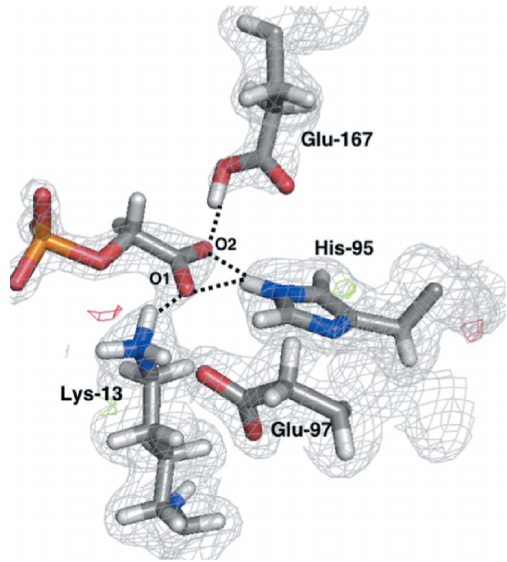
Figure 4 Quantum-refined joint X-ray/neutron structure of PGA–TIM with the 2 mF o (cid:5) DF c nuclear scattering-length density map contoured at 1.0 (cid:2) and the mF o (cid:5) DF c nuclear scattering-length difference density maps contoured at 3.0 (cid:2) (green) and (cid:5) 3.0 (cid:2)